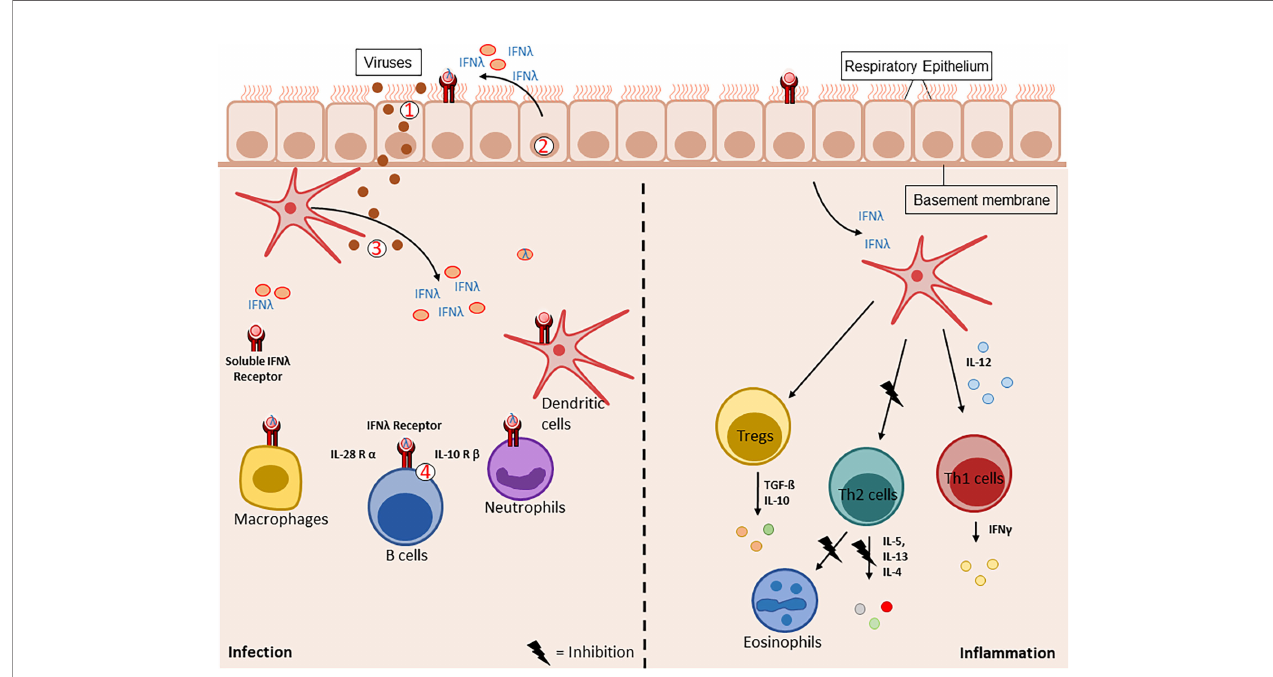
FIGURE 2 | Graphical illustration of the IFN l family members production and release during virus infection (left) vs in fl ammation (right). Upon viral stimulation (1), the epithelial cells (2) and dendritic cells (3) are the main producers of type III interferons. The epithelial cell barrier therefore is the fi rst defense line against viral infections. After the release of type III interferons, they bind to their speci fi c receptor the IFN l R (4). This receptor is expressed on different cell types like macrophages, dendritic cells, neutrophils, B-cells and epithelial cells. During in fl ammatory processes, IFN l activates dendritic cells to produce IL-12. This activates the Th1 immune response and thereby suppresses Th2 mediated in fl ammation like recruitment of eosinophils to the site of in fl ammation. Under these conditions, the Treg function is maintained and supports the lung homeostasis by resolving the airway in fl